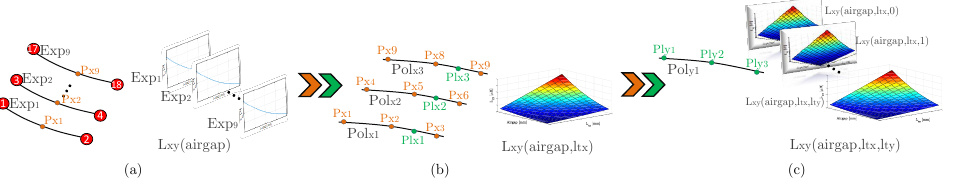
Figure 7. Step by step illustration of the fitting methodology for ( a ) L xy = f ( airgap ) , ( b ) L xy = f ( airgap , l tx ) and ( c ) L xy = f ( airgap , l tx , l ty ) . 4. Replace airgap in equations Exp 1 to Exp 9 with the desired value to determine L xy in points P x 1 to P x 9 , as illustrated in Figure 7a. The new L xy values take into account the effect of the selected set of turns and air gap values. 5. Profile of L xy = f ( l tx ) : Use the values found in Step 4 that have the same airgap and l ty values, such as P x 1 to P x 3 , to determine the Gaussian constants a 2 , b 2 and c 2 in (8). Repeat the process (if applicable) for the set of points P x 4 to P x 6 and P x 7 to P x 9 . A total of one or three equations is determined according to the shape of the